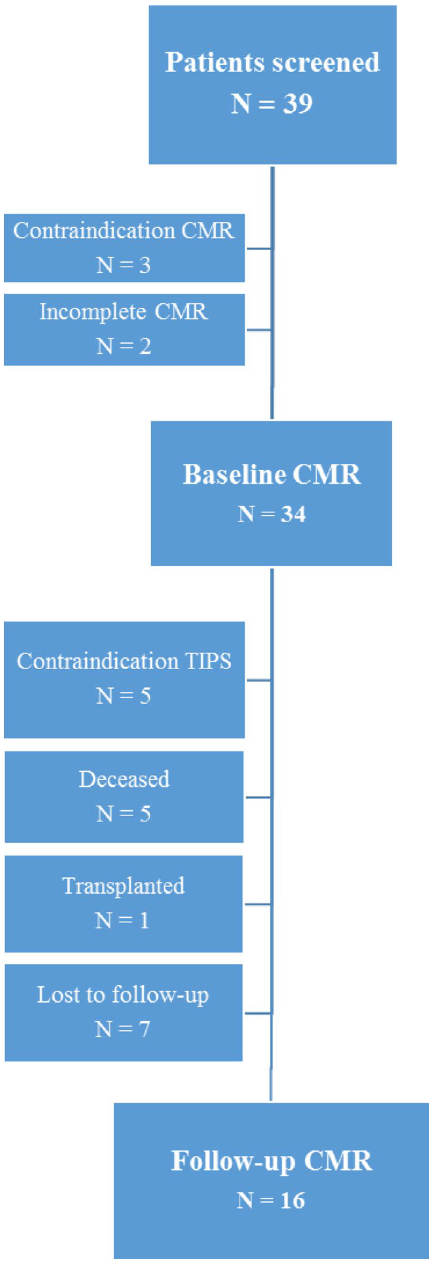
Figure 1. Flow chart of prospective consecutive screening, inclusion and exclusion of